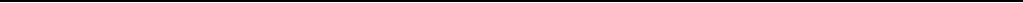
Table 1. Measurements of forceps impacts. Measurements of background noise levels, noise produced when dropping metalforcepsindifferent circumstances asdescribed, thedifferencebetween background andmeasured impact noise and the reduction when using a neoprene mat as a noise control measure. IVC: individual ventilated cage; BG: